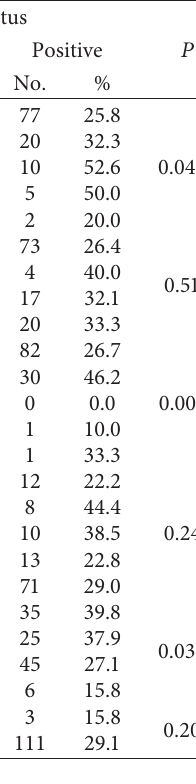
Table 4: Distribution of students’ tinnitus status according to exposure to different risk factors,